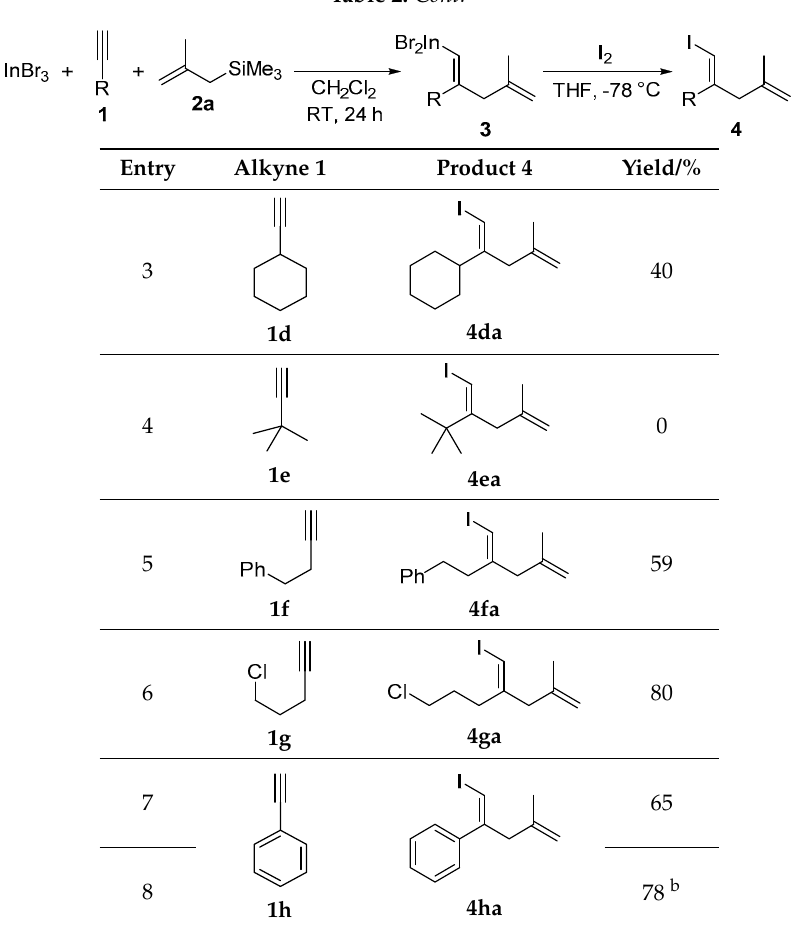
Table 2. Scope and limitation of alkyne 1 in allylindation a . Table 2. Cont.